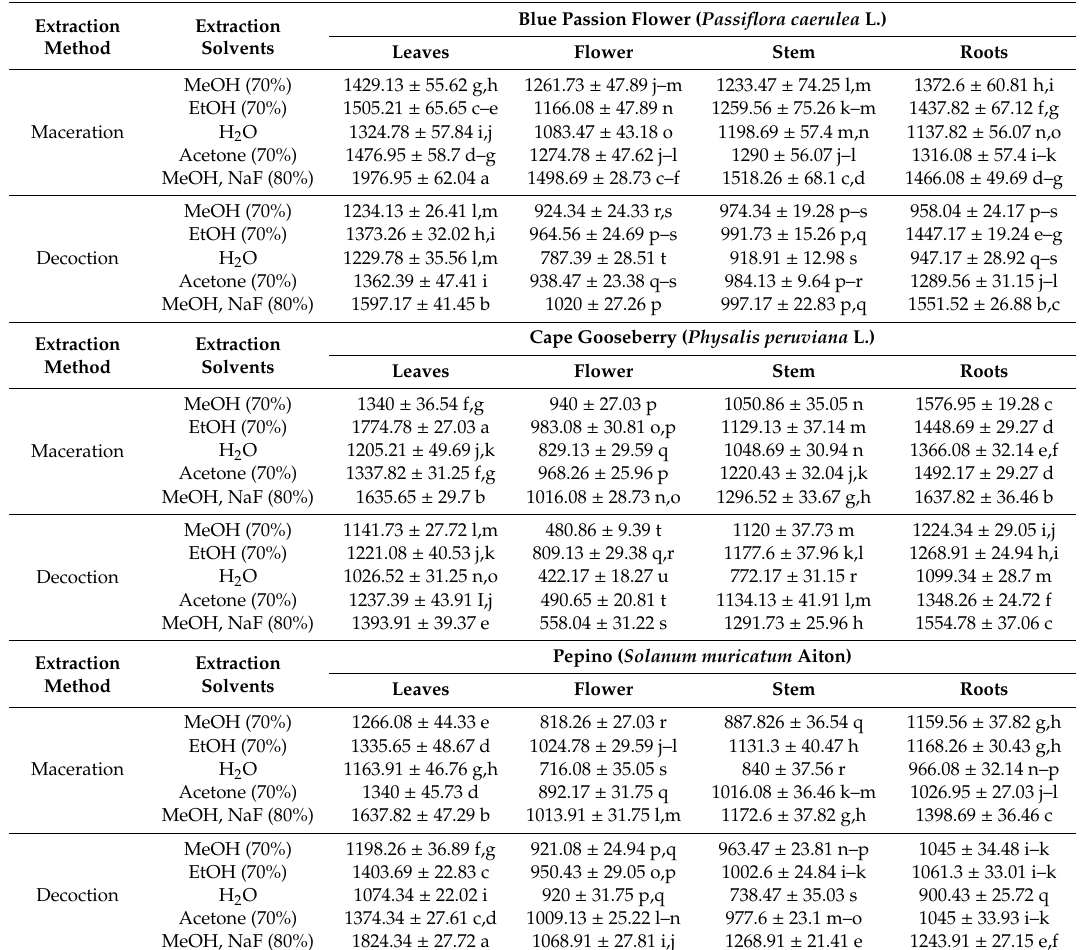
Table 2. Total polyphenol content (mg eq GA / 100 g DM) in the di ff erent parts of blue passion flower ( Passiflora caerulea L.), cape gooseberry ( Physalis peruviana L.) and pepino ( Solanum muricatum Aiton) extracted by decoction and